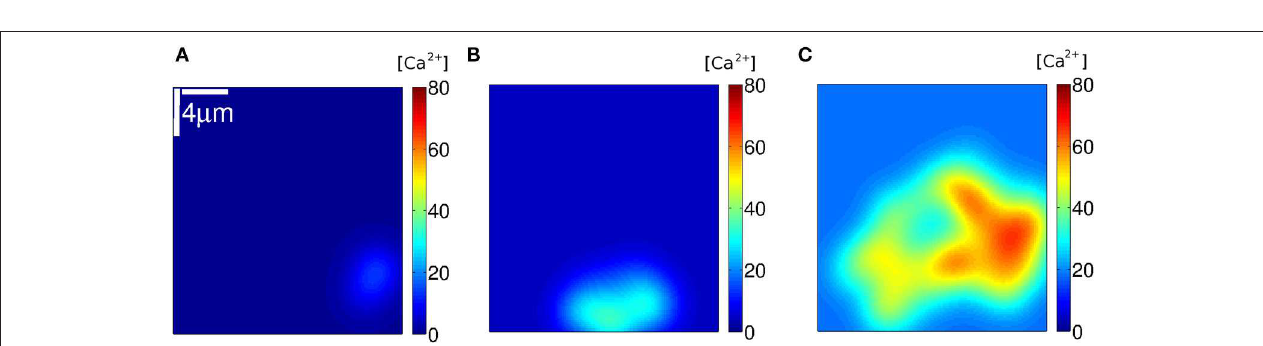
68, (B) to 203 and (C) to 255. =